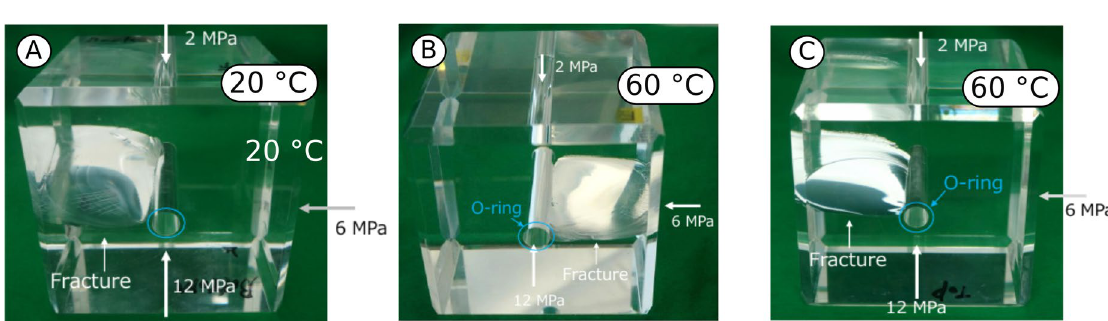
Figure 5. Images of the post-mortem samples tested following procedure P2 (see Methods) at 20 ◦ C and 60 ◦ C. The complex fracture pattern observed with procedure P1 disappears, and overall a classical pure mode-I planar hydro-fracture develops independently of